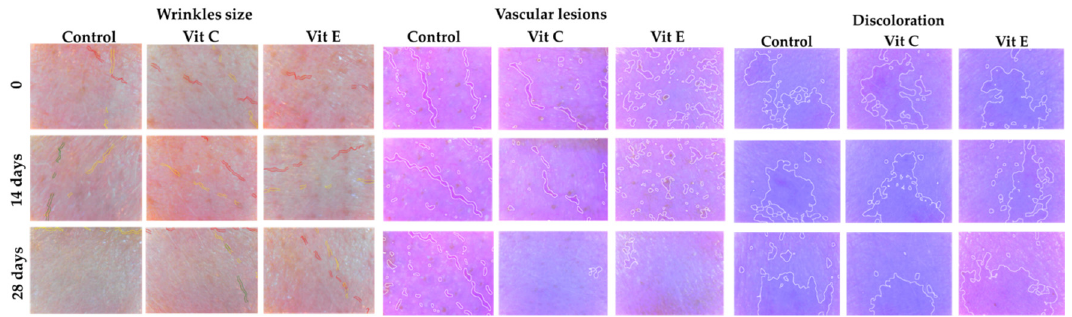
Figure 7. Images of wrinkle size, vascular lesions and discoloration for the tested skin.